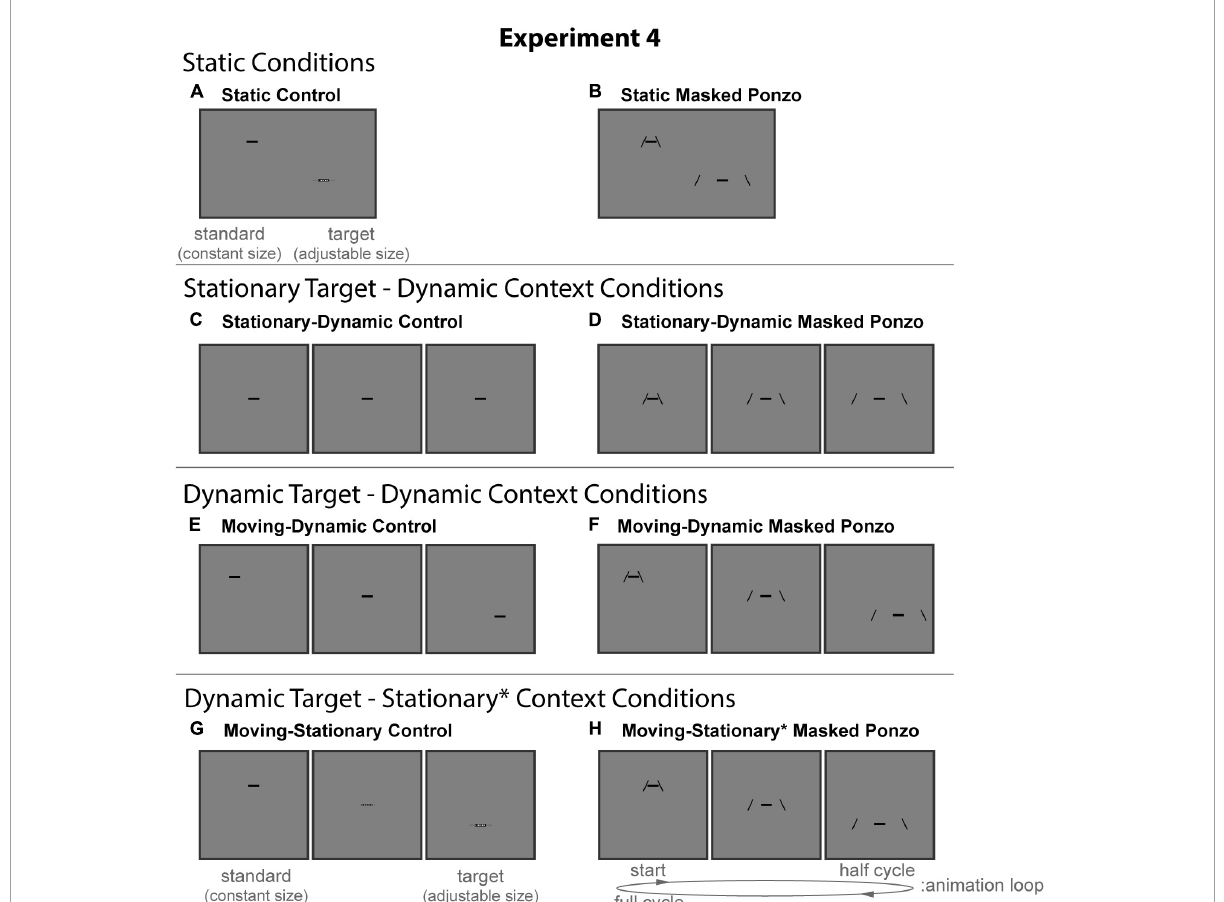
FIGURE8 The eight conditions of Experiment 4. Columns represent the two distinct contexts [Control (A,C,E,G) , Masked Ponzo (B,D,F,H) ]. Rows represent the four configurations [Static (A,B) , Stationary-Dynamic (C,D) , Moving-Dynamic (E,F) , Moving-Stationary (G,H) ]. For each condition, screenshots for the beginning (standard circle), middle, and end (target circle) frames are shown. The animation [as labeled in panel (H) ] played in a continuous loop. In the figure, the horizontal line is the same physical size in all frames; during the experiment, the target (lower right line for Static conditions or the far-right frame for Dynamic conditions) was adjusted by the participant [see panels (A,G) ]. Here, stimuli are cropped to display the central portion of the screen to save space. Supplementary Video 4 showing all of the dynamic conditions for Experiment 4 can be found in the Supplementary materials (best viewed in “loop”